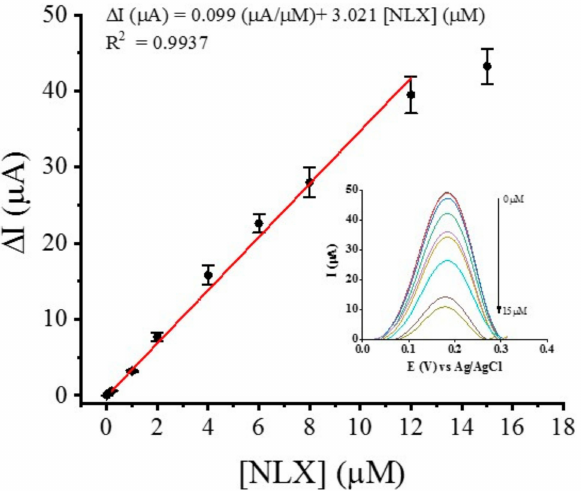
Figure 5. Calibration plot of the pyrrole@sol-gelMIP/fMWCNT/ITO sensor using different concen- trations of NLX. The inset shows the DPV curves of the sensor using 1 mM [Fe(CN) 6 ] 3 − /4 −